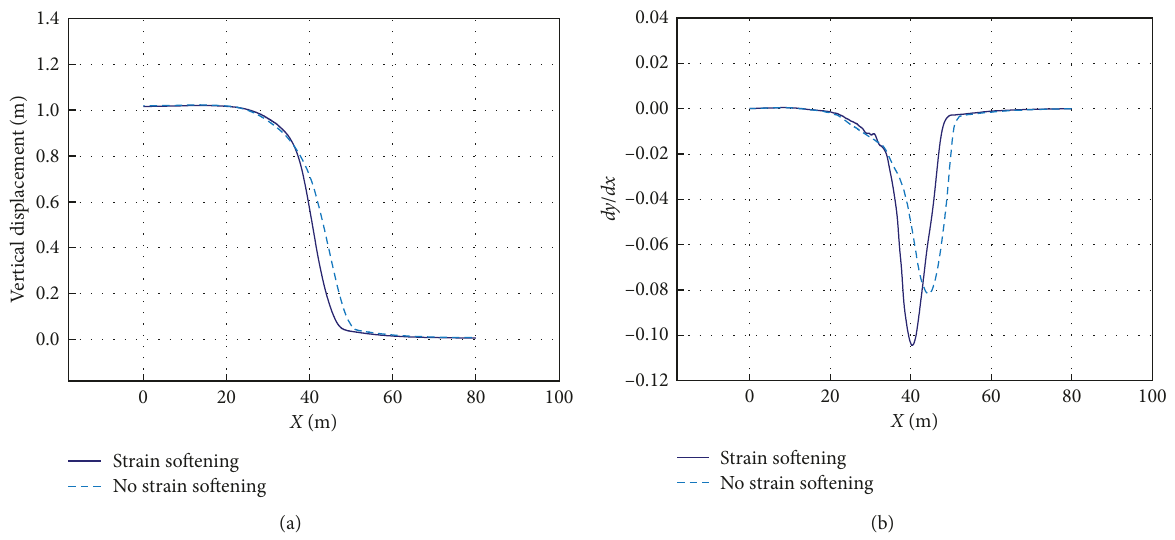
Figure 3: The displacement of the ground surface: (a) vertical displacement and (b) tilt